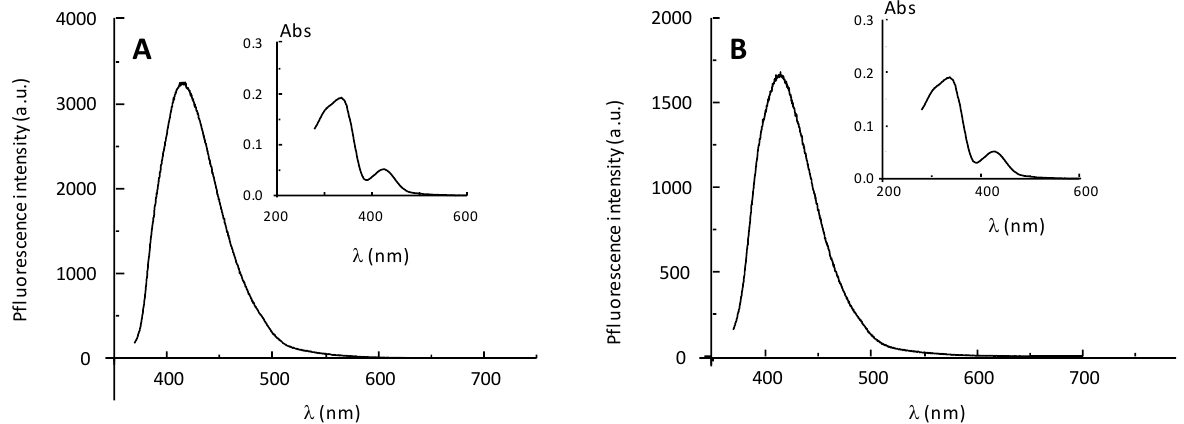
Figure 1. UV-vis absorption (insets) and fluorescence emission spectra of P797 (( A ) left graph) and P794 (( B ) right graph) at 1 × 10 − 5 mol.dm −3 in acetonitrile + TBABF 4 at 0.1 mol.dm −3 . Excitation wave- length ( λ ex ) = 350 nm for fluorescence spectra.